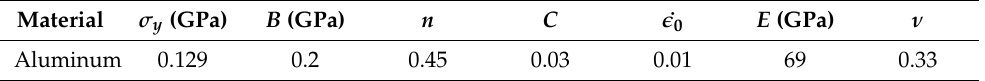
Table 1. Parameters used for the Johnson-Cook material model with an aluminum target (99.0%) [21]. Material σ y (GPa) B (GPa) ν